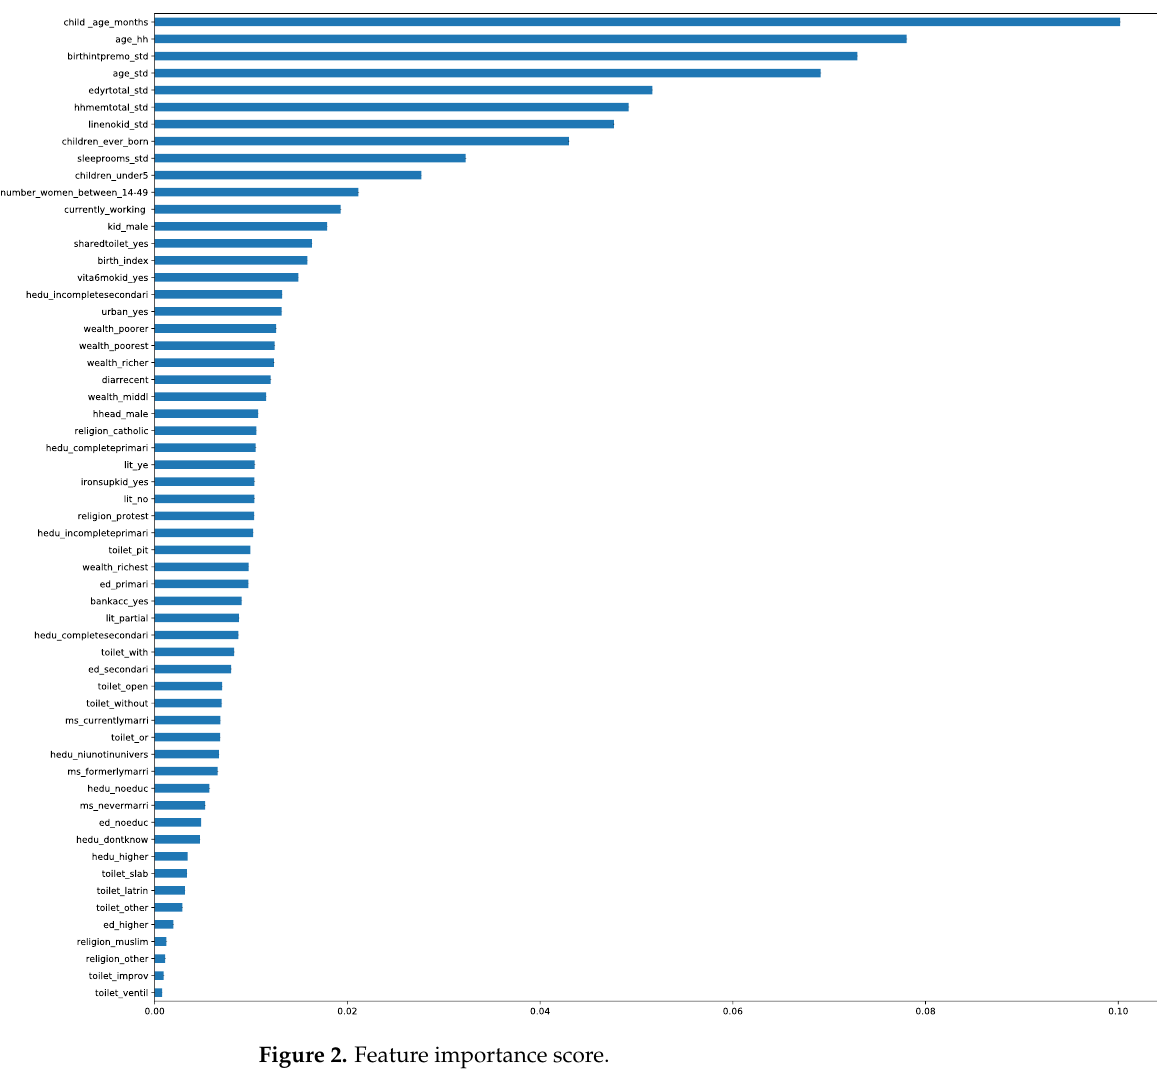
Figure 2. Feature importance score.